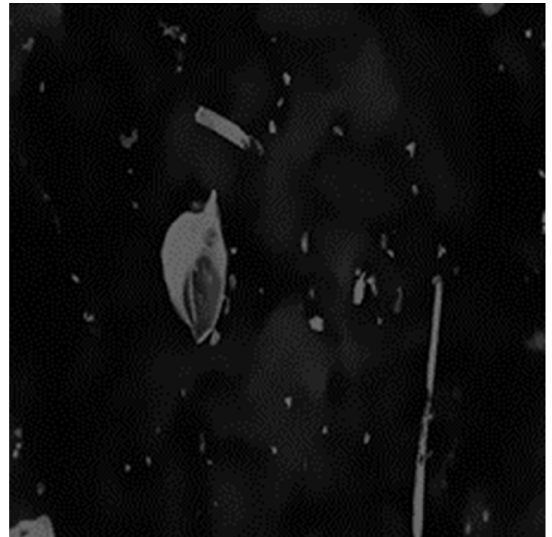
Figure 8. NLM algorithm noise reduction.